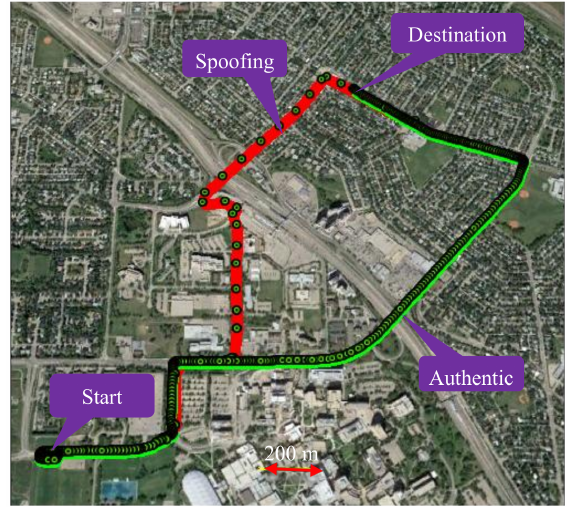
Figure 4. Data collection scenario in suburban environment. Green and red lines are the authentic and spoofed